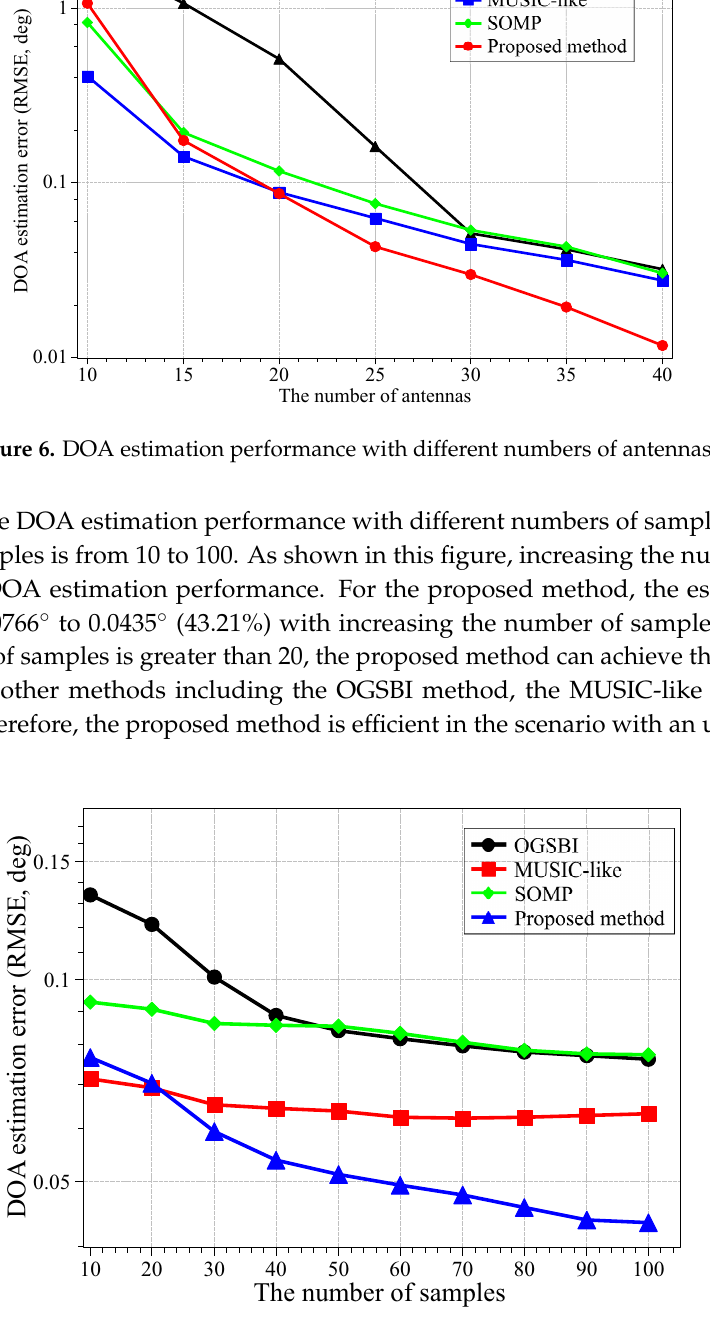
Figure 7. DOA estimation performance with different numbers of